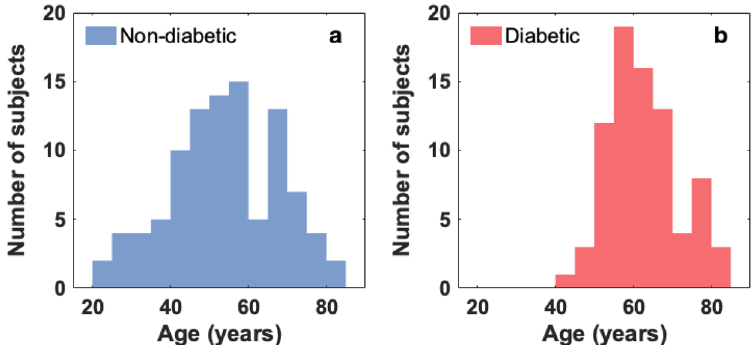
Figure 1. Age distribution of ( a ) non-diabetic group and ( b ) diabetic